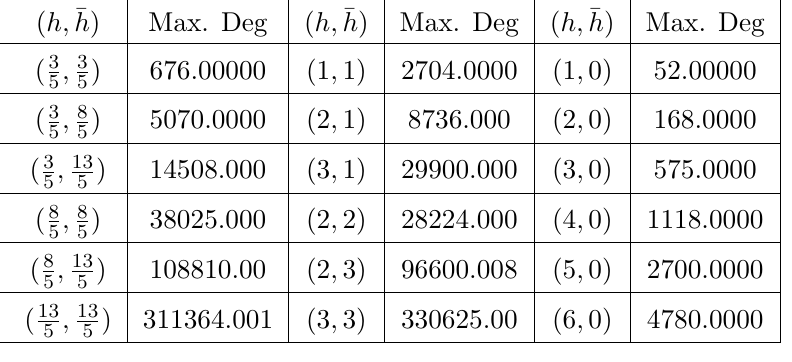
Table 16. Degeneracies of the (cid:12)rst few states in c = 26 We used the W (2 ; 6 ; 8 ; 12) character with c = 26